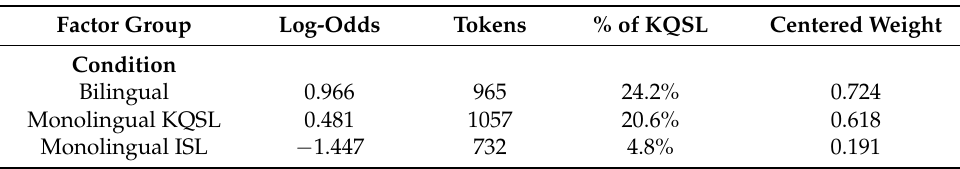
Table 6. Significant Rbrul results (by condition).